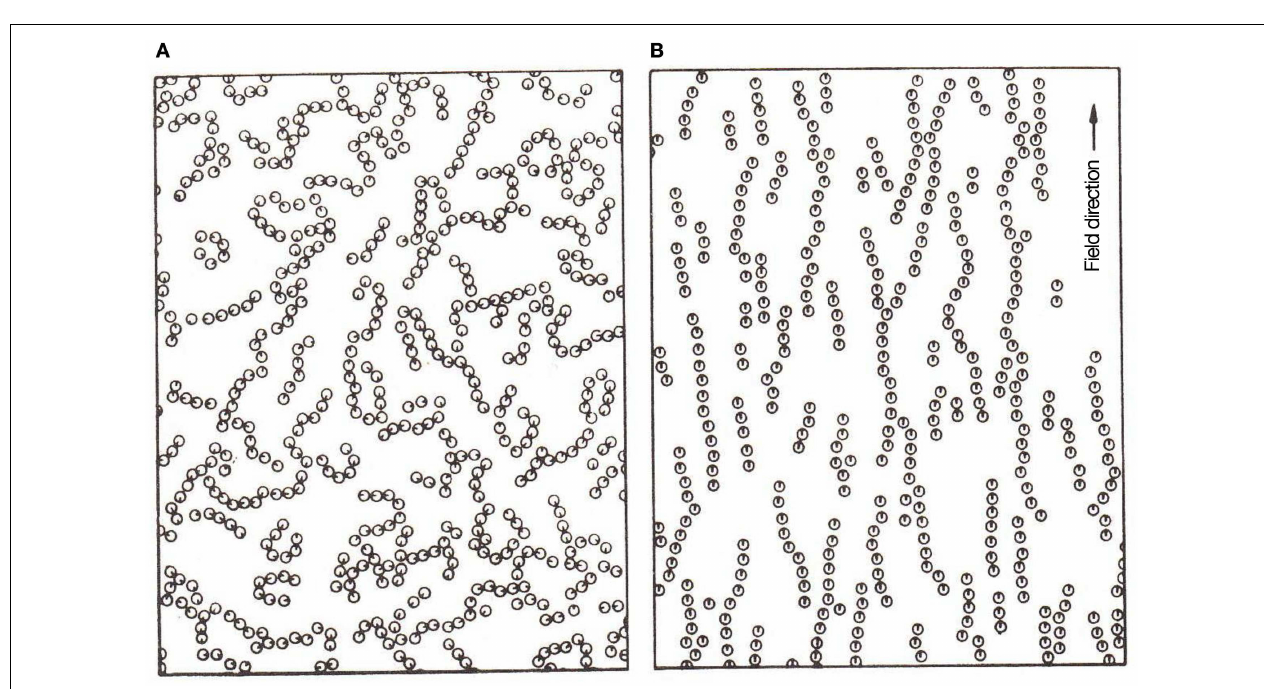
magnetic moments rotate within the (fixed) nano-particle.